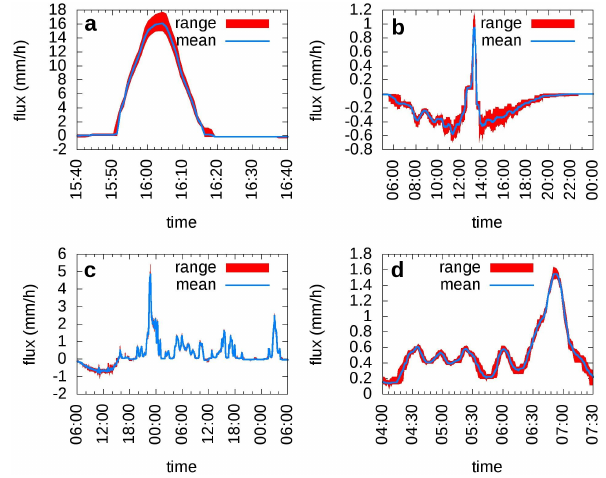
Figure 7. Short time dynamics of precipitation events for selected rain events of 9 May 2013 (a) , 4 May 2013 (b) , 26–28 April 2013 (c) and 12 April 2013 (d) .